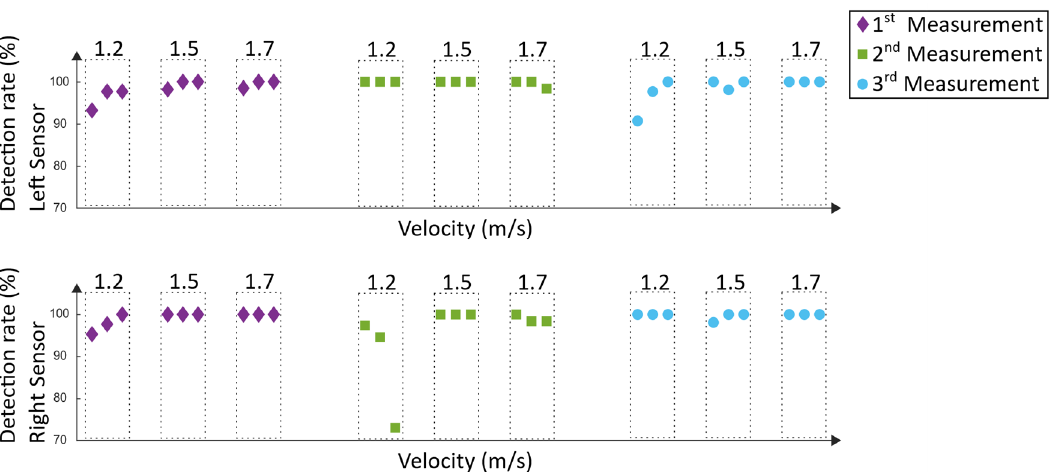
Figure 22. Detection rate of the Lokomat measurements.